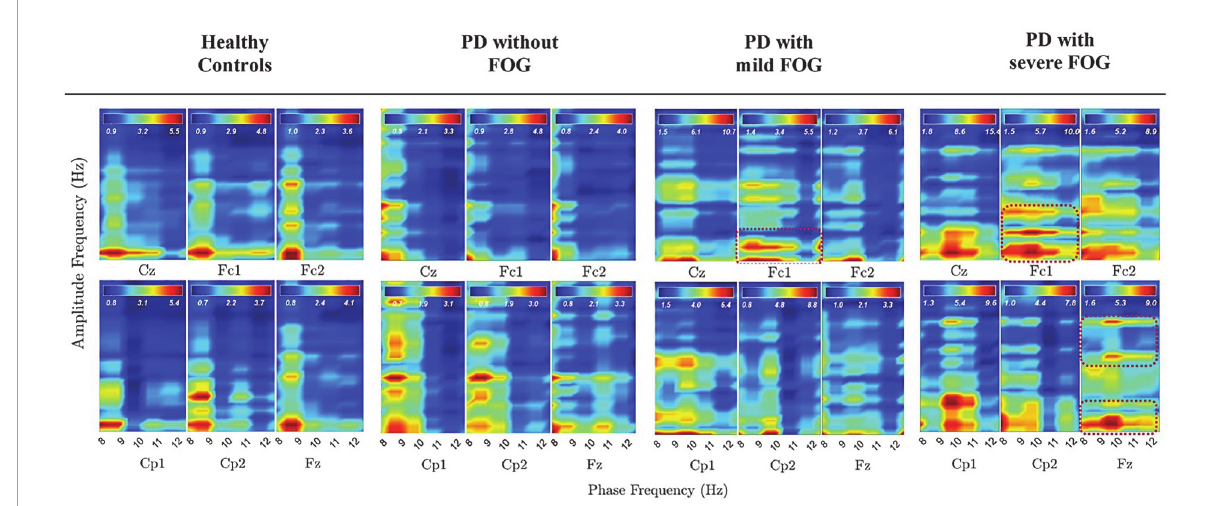
FIGURE4 PAC between alpha and beta frequency bands without SL over [–3, 2] s in all groups. Dashed red lines represent PAC between all alpha frequency sub bands and low beta and high beta in PD with